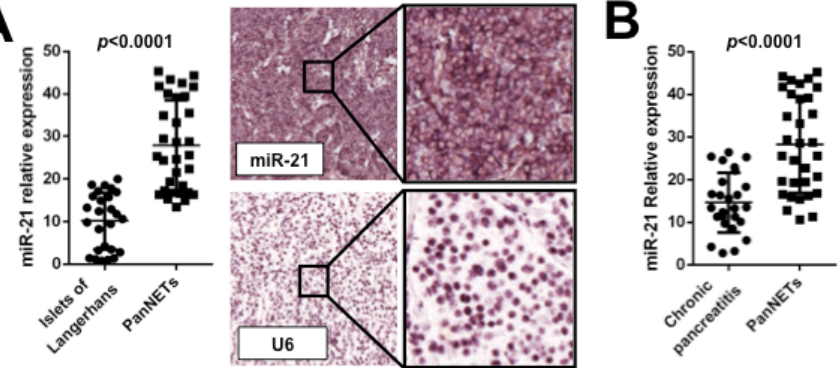
Figure 2. miR-21 is significantly overexpressed in pancreatic neuroendocrine tumors and it is detectable in patients’ plasma samples. ( A ) Pancreatic neuroendocrine tumors (PanNETs) usually show a significantly higher miR-21 expression in comparison to normal pancreatic Langerhans islets (qRT-PCR). This overexpression is confirmed by in situ hybridization (upper panel: a PanNET showing strong miR-21 staining; lower panel: same case stained with the positive control U6). ( B ) In PanNET patients, circulating cell-free plasma miR-21 is overexpressed in comparison to chronic pancreatitis patients and could be used as a novel diagnostic